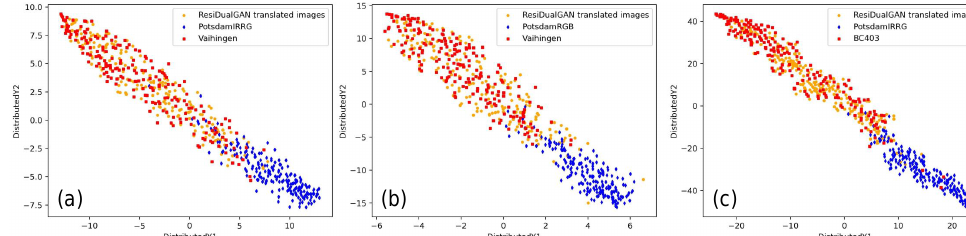
Figure 8. Visualization of the t-SNE [48] results of ResiDualGAN. Every point in the figure refers to the t-SNE dimension reduction result of the feature of an image. The feature is obtained from the encoder of the ResNet-18 [44] network. The orange dots refer to features of images generated by ResiDualGAN under the image translation tasks from ( a ) PotsdamIRRG to Vaihingen, ( b ) Potsdam- RGB to Vaihingen, and ( c ) PotsdamIRRG to BC403. The other points refer to features of images from